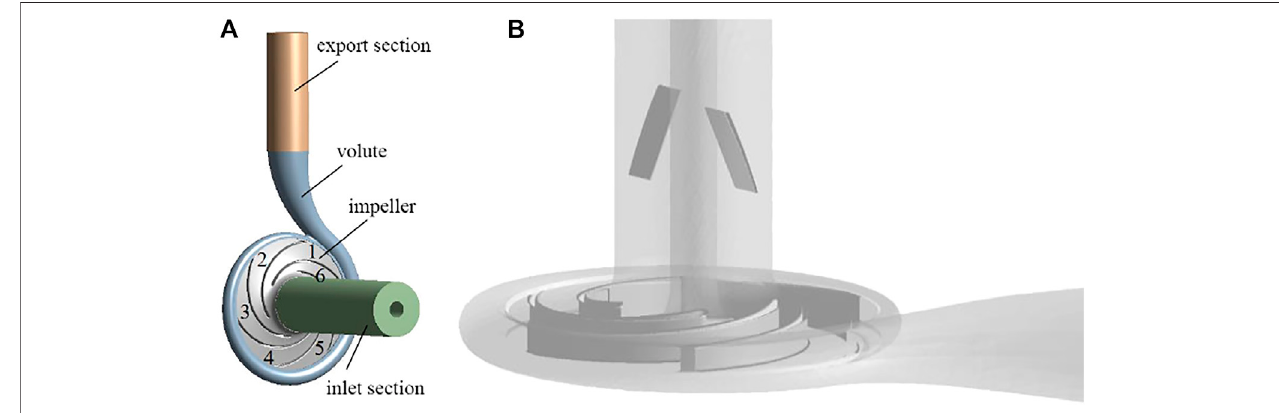
FIGURE 1 | Three-dimensional model of the centrifugal pump: (A) geometric model; (B) overall perspective view of the centrifugal pump with IGVs.